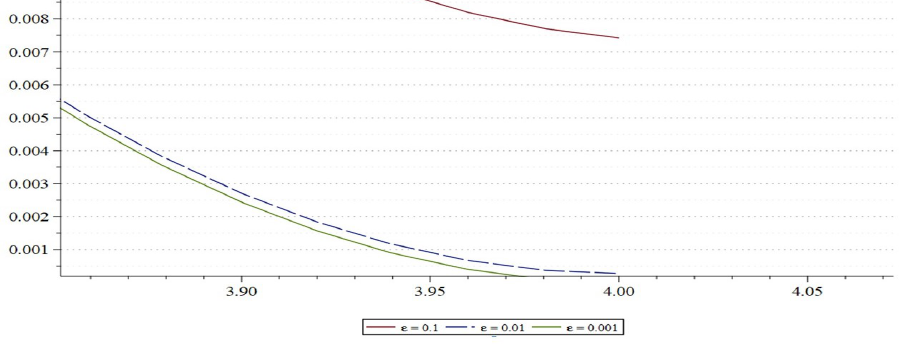
Figure 4. A zoom of z 1 ( 4 ) for varying ε .